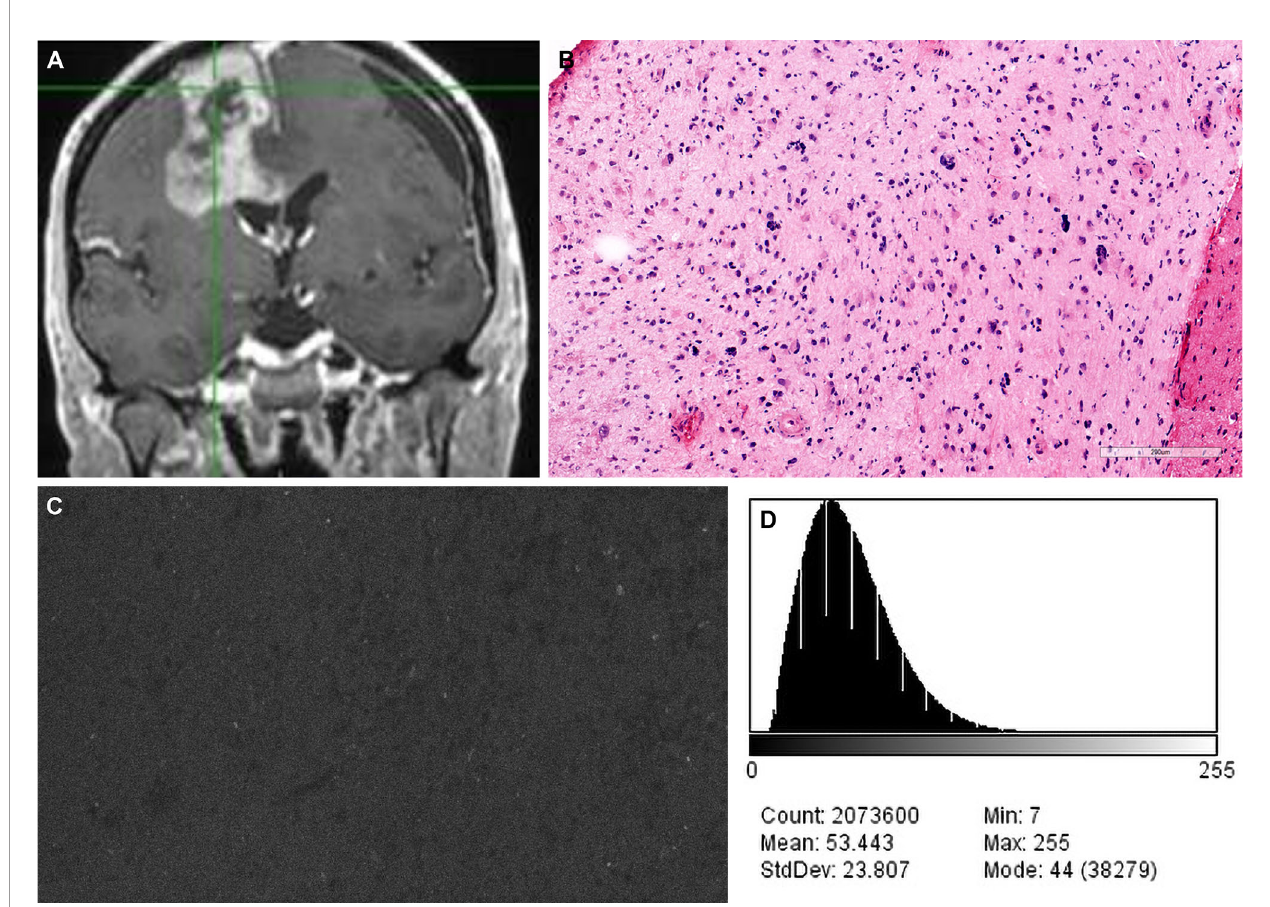
FIGURE 6 | Case example of confocal laser endomicroscopy (CLE) images acquired after a single dose of fl uorescein sodium (FNa) before the concept of redosing was introduced. (A) Coronal T1-weighted magnetic resonance image with contrast. Biopsy specimens were obtained from the enhancing tumor in the left frontal lobe. (B) A diagnosis of high-grade glioma was made on the basis of H&E staining of biopsy specimens. (C) A CLE image acquired 180 minutes after FNa injection is dark and noninterpretable. (D) A corresponding histogram shows the intensity values of the CLE image. Count, number of pixels; Mean, brightness; StdDev, contrast; Min and Max, minimum and maximum gray values within the image; Mode, most frequently occurring gray value within the selection corresponds to the highest peak in the histogram. Used with permission from Barrow Neurological Institute, Phoenix,